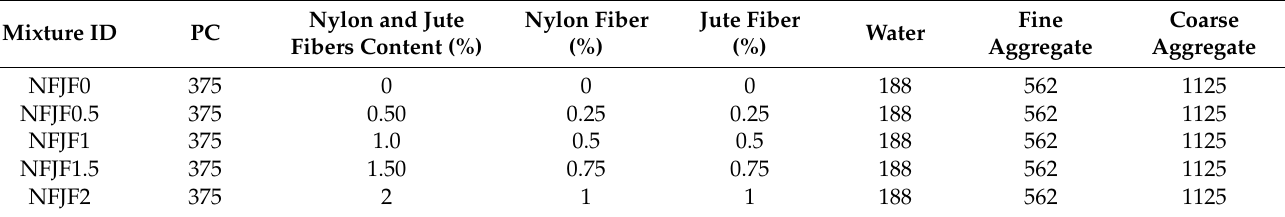
Table 4. Mix proportions (kg/m 3